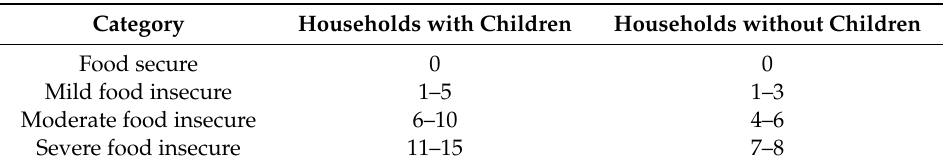
Table 1. Latin American and Caribbean Food Security Scale (ELCSA)’s food security categories and required a ffi rmative answers. Source: